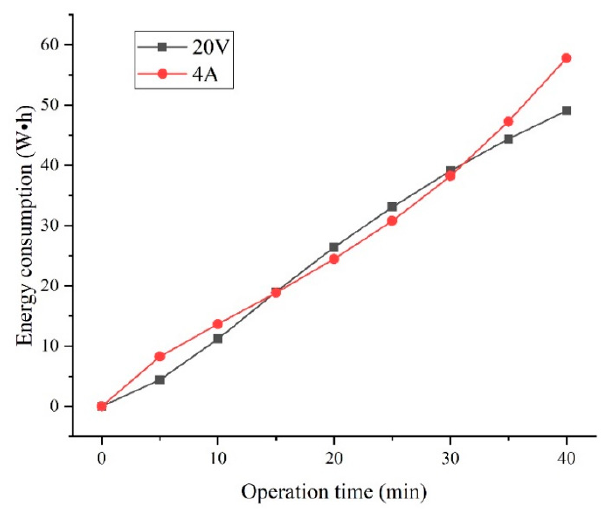
Figure 10. Energy consumption of the device under different operation conditions.